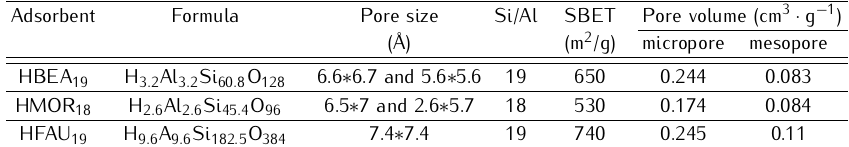
Table 1. Characterization of the Zeolite Samples.